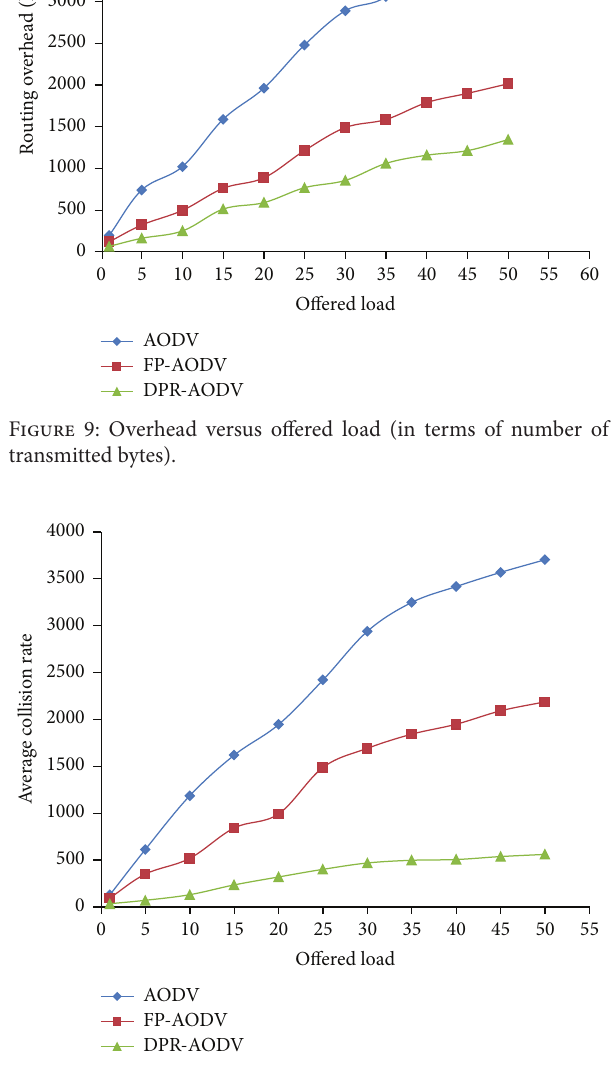
Figure 10: Average collision rate versus offered